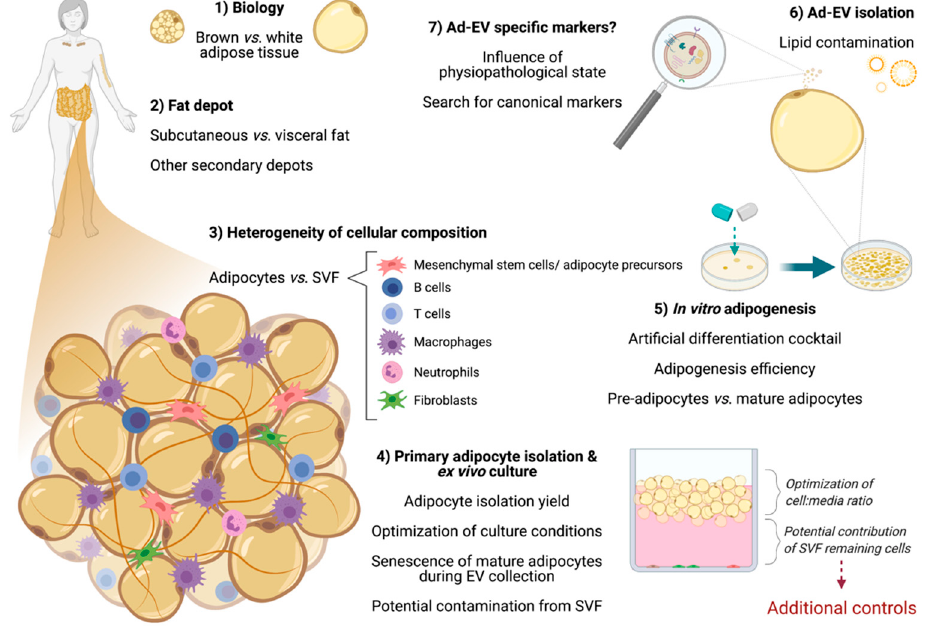
Figure 3. Biological and technical aspects to consider when working with adipose cells. Schematic overview of principal aspects related to white adipose tissue biology and the methodological ap ‐ proaches for its study. Derived challenges for each point are also addressed. Most of the studies performed up to date are based on adipose tissue explants (implying a heterogeneous population of derived extracellular vesicles) or adipogenesis in vitro models. Primary adipocyte ex vivo culture conditions are still a current challenge (due to the lack of standardization) and additional con ‐ trols in future studies are highly advisable (especially regarding the potential contamination of the stromal ‐ vascular fraction (SVF)). Lipid contamination during adipocyte ‐ derived (Ad) ‐ EV isolation has recently been shown as a potential drawback. The absence of specific Ad ‐ EV markers remains an obstacle in the field. Ad ‐ EV, adipocyte ‐ derived extracellular vesicles; SVF, stromal ‐ vascular fraction. This figure was created with BioRender.com (accessed on 16 March 2020).